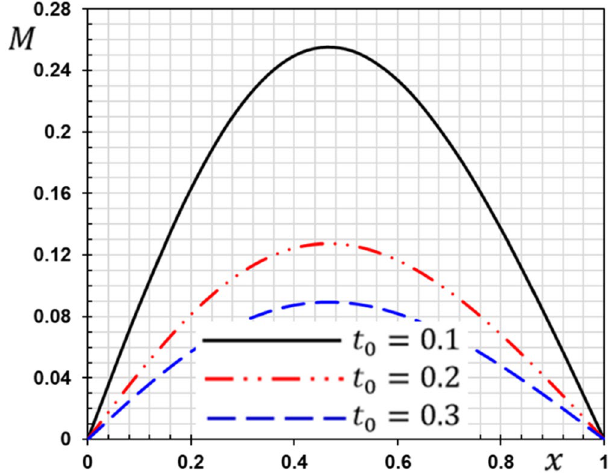
Figure 9. The influence of ramping time t 0 on the flexure moment.